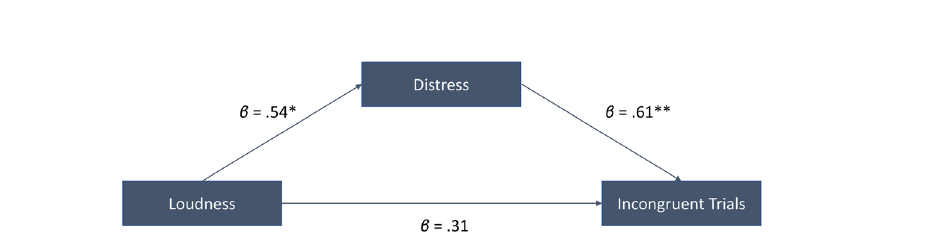
Figure 5. Mediation analysis between loudness, distress, and incongruent trials controlling for age, gender, hearing loss, cognitive ability, depression, anxiety, and sleep